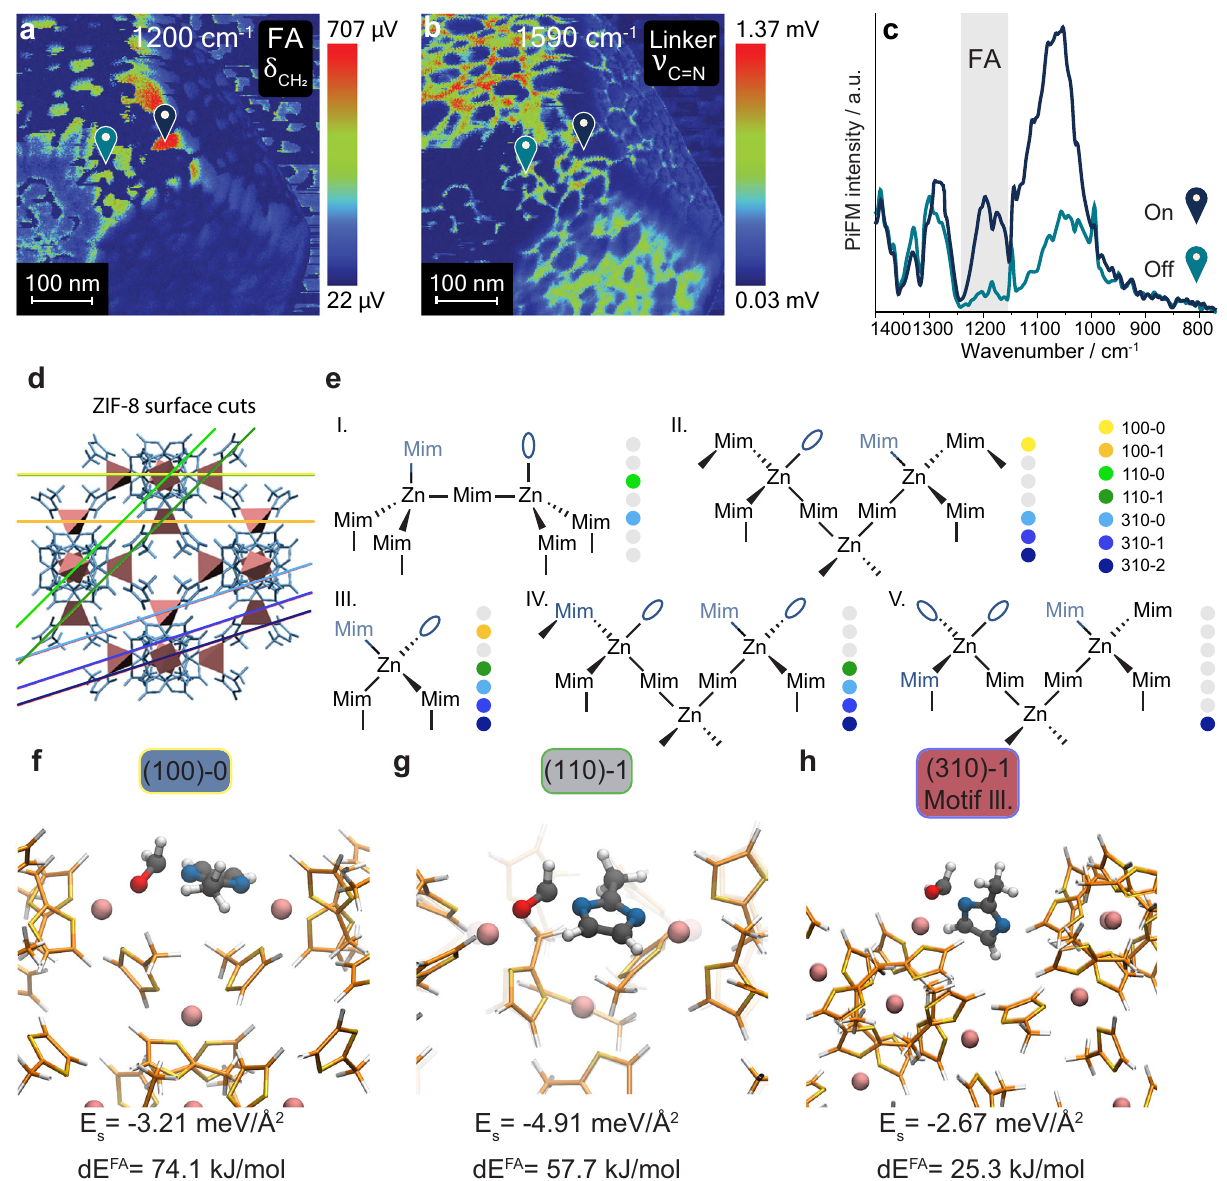
Fig. 3 | Experimental and theoretical descriptions of heterogeneous gas sorp- tion on various ZIF-8 surface terminations. a Representative infrared image mappingachemisorbedformaldehydevibration(1200cm − 1 ),showingthepresence ofnanoislandsofalternatesorptionbehaviorwithinthepristine{100}and{110}ZIF- 8 facets. b Infrared map of a ZIF-8 framework vibration (1590cm − 1 ), showing an inverted image, ruling out topography-induced PiFM signal. c Point spectra were taken on and off the nanoislands (markers in ( a , b )) showcase non-homogenous sorption behavior, as well as the validity of the IR mapping technique. d Crystal